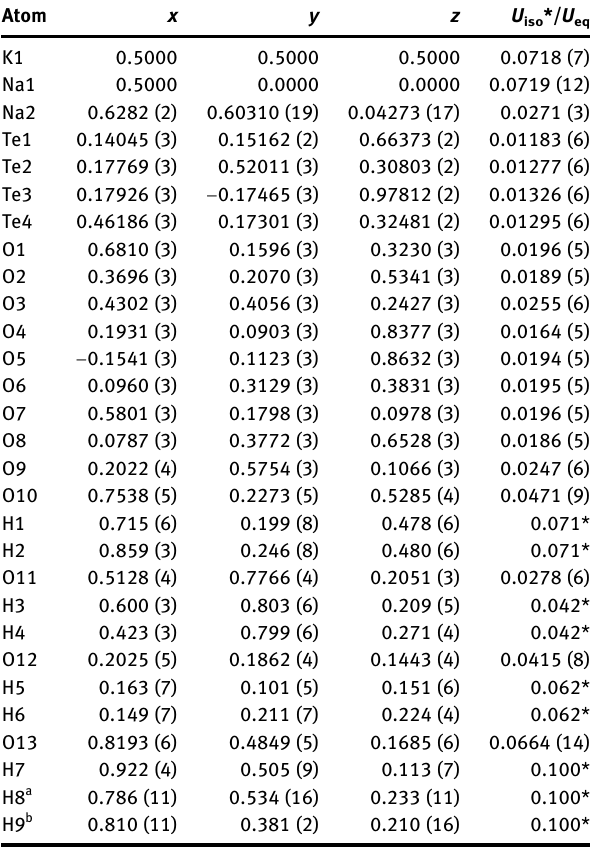
Table  : Fractional atomic coordinates and isotropic or equivalent isotropic displacement parameters (Å 